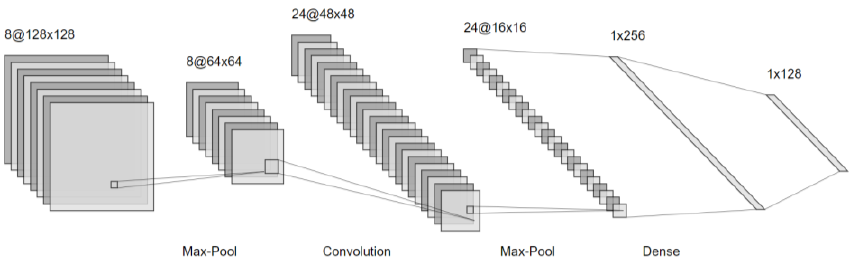
Figure 7. Convolution neural networks.